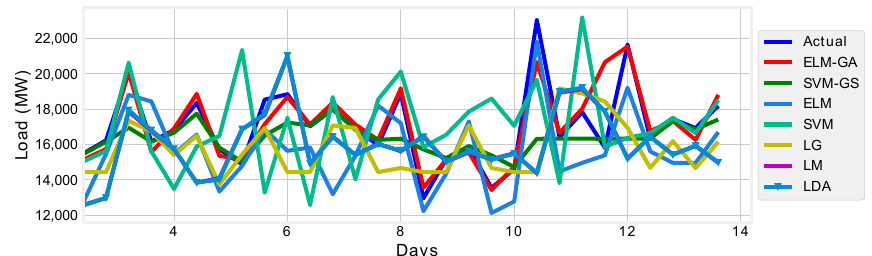
Figure 13. Forecasting of proposed technique with respect to the State of the Art (SOTA).